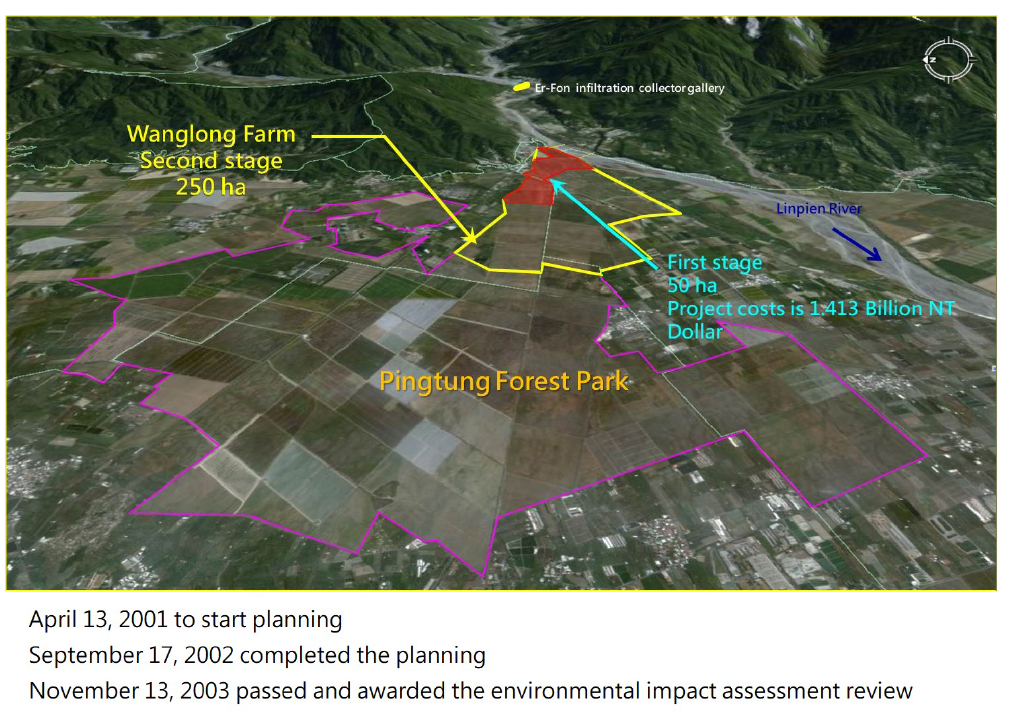
Figure 2. Location map of the Artificial Recharge of Groundwater Project implemented in Pingtung, Taiwan (Pingtung County Government,